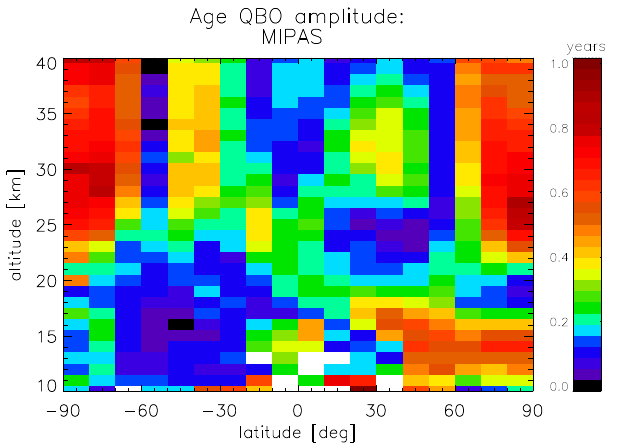
Figure 10. Calculated AoA trends for 2002–2012 from the KASIMA model with consideration of empirical errors and auto- correlation. Hatched areas indicate where the trend is not signifi-